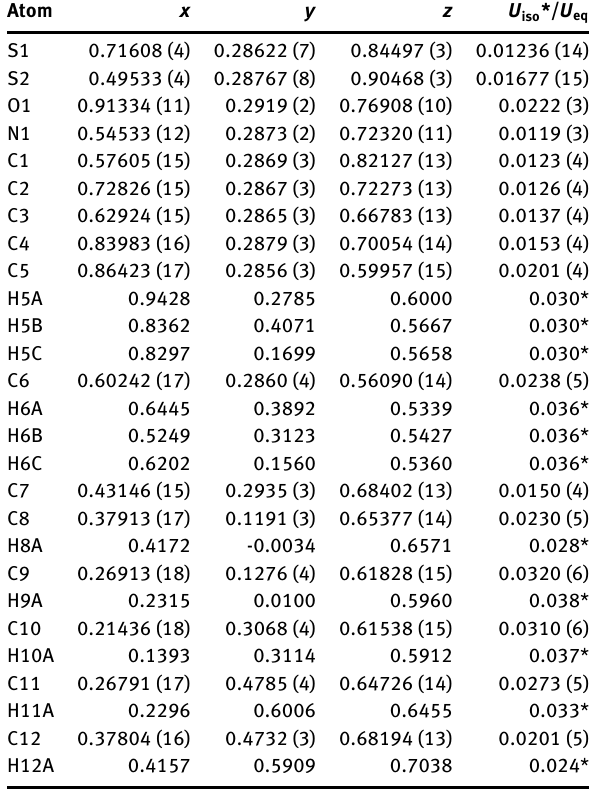
Table 2: Fractional atomic coordinates and isotropic or equivalent isotropic displacement parameters (Å 2